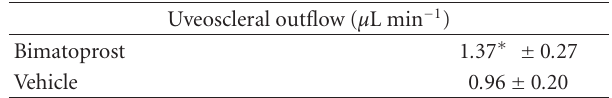
Table 2: E ff ect of bimatoprost (0.01%) administered twice daily for 5 days on uveoscleral outflow ( μ L min − 1 ) in cynomolgus monkeys ∗ P < . 05, n = 6 (Mean ± SEM).